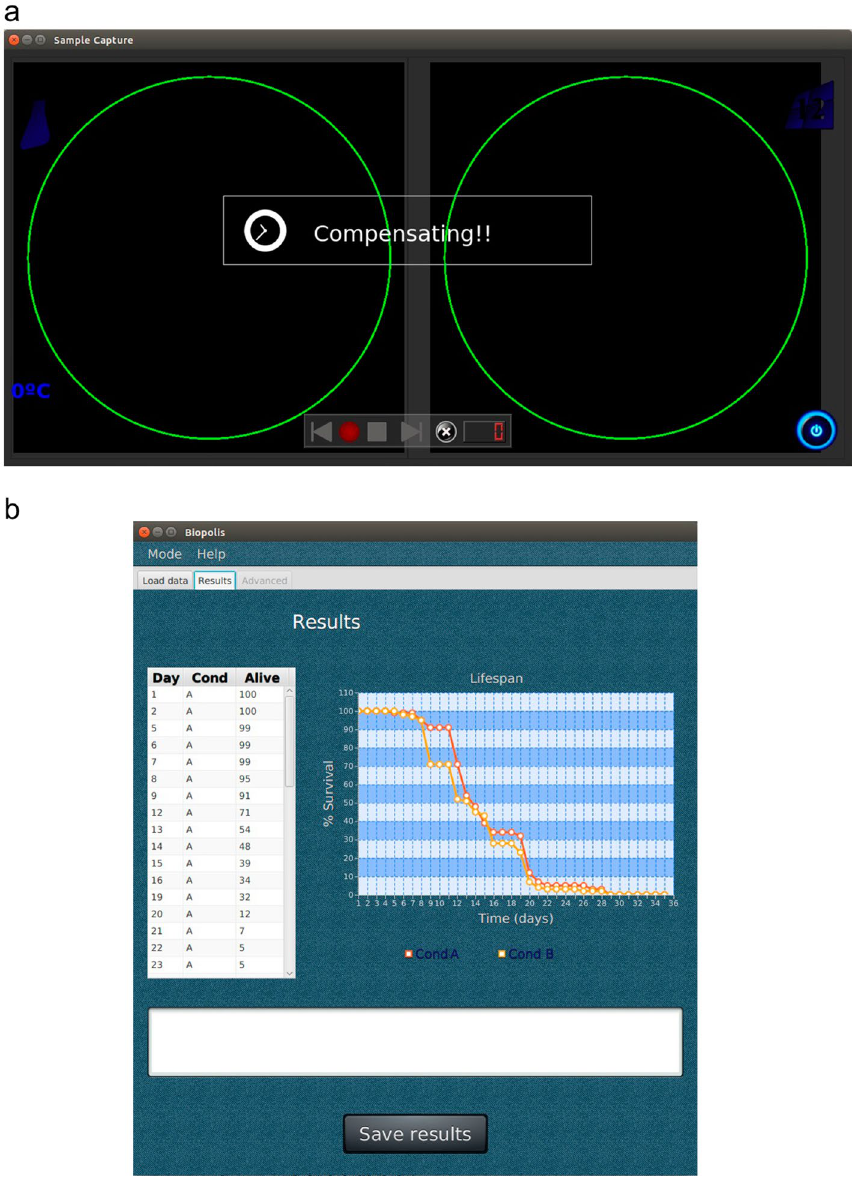
Figure 3. Graphic user interfaces. ( a ) CaptureCE interface is like a video player which shows the two pallet plates in real time. Experiments are created and the experiment to be captured is selected. ( b ) ProcessorCE interface is used to select captured experiments to be processed and provide the corresponding survival results.